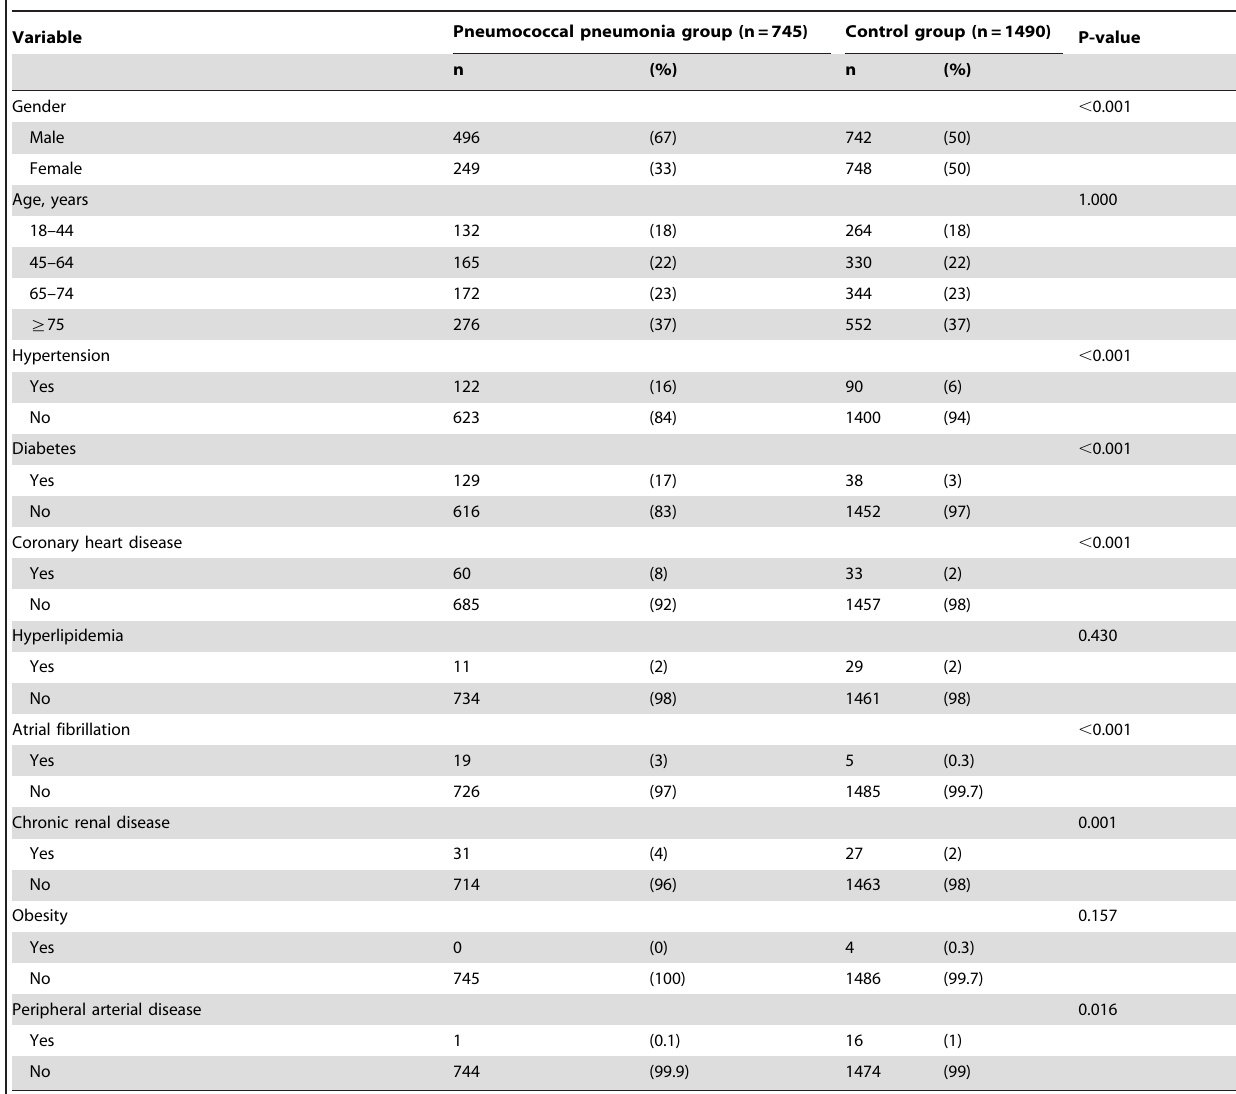
Table 1. Demographic characteristics and comorbidities of the pneumococcal pneumonia and control groups in Taiwan, 2004